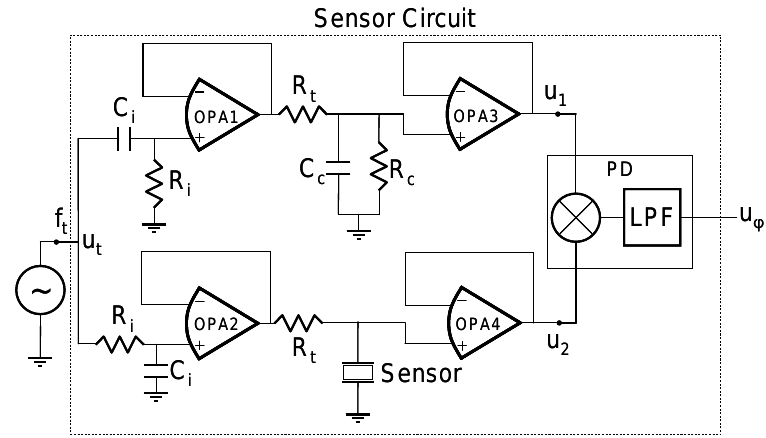
Figure 4. Schematics of the interface system for the sensor phase